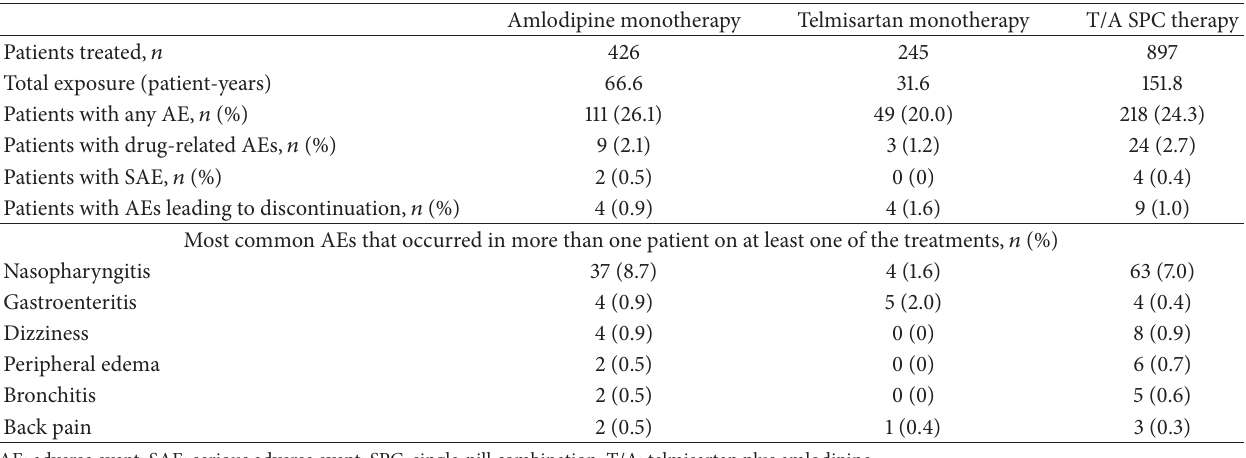
Table 5: Safety results of 8 weeks’ treatment with T/A combination or the respective